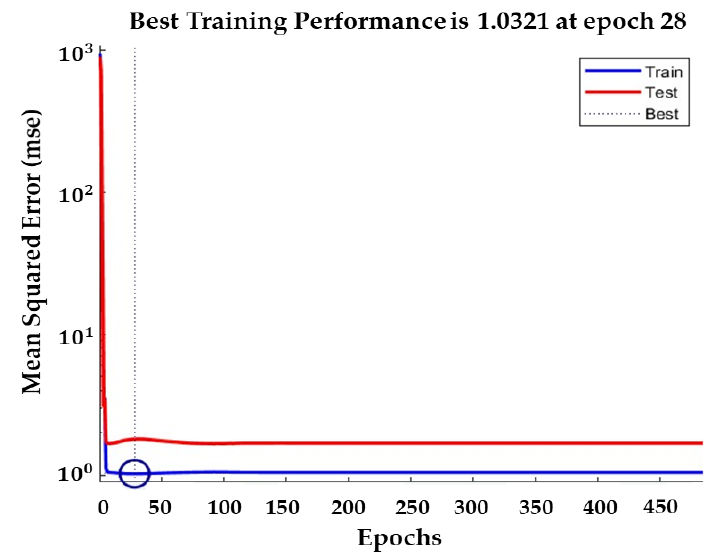
Figure 10. ANN convergence performance for training and testing steps.